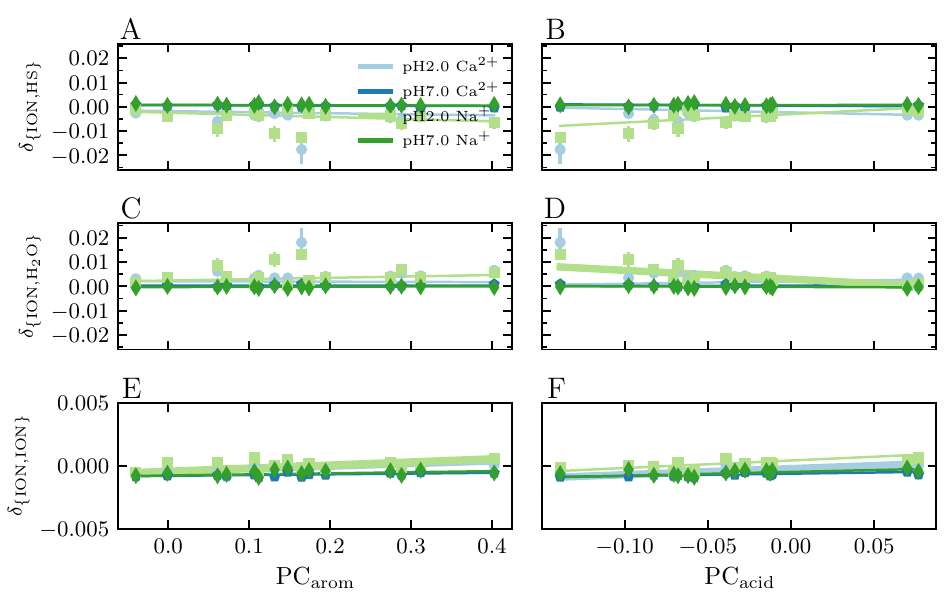
Figure 8. Preferential solvation of cations with different species (HS, H 2 O and Ca 2 + ) of the standard humic substances models. Plots show the preferential solvation with ( A , B ) the humic substances, ( C , D ) water and ( E , F ) cations (calcium or sodium) in function of their PC arom and PC acid . Each point represents the average over four independent simulations with error bars representing the standard error. Notice the different y -axis scales in our